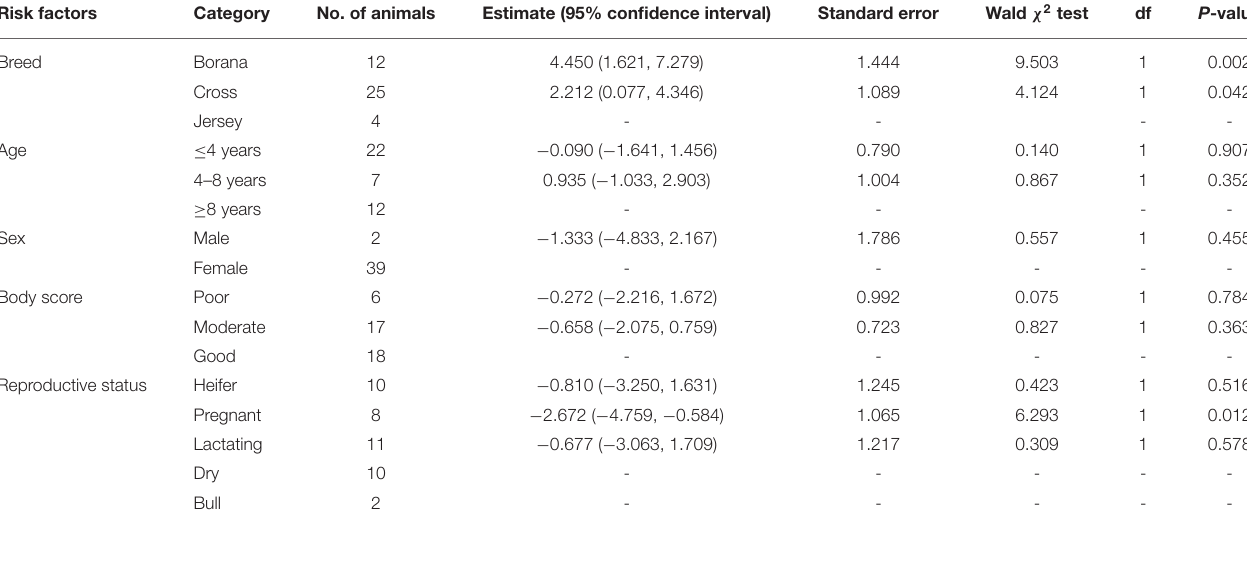
TABLE 3 | Association of different risk factors with the severity of pathology in 41 (two animals with 0 pathology score were not considered in the analysis) cattle using multivariable ordinal logistic regression. Risk